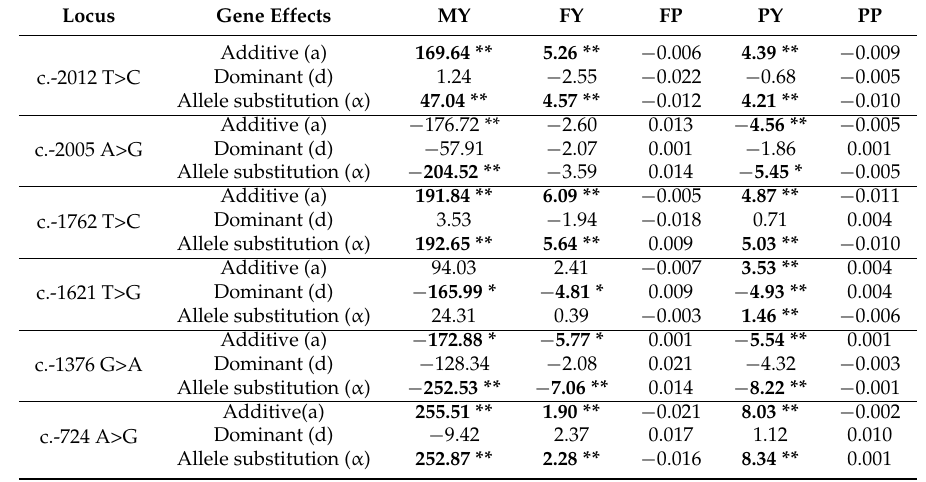
Table 4. Genetic effects of these SNPs on the five traits in dairy cattle. Notes: * p < 0.05; ** p <